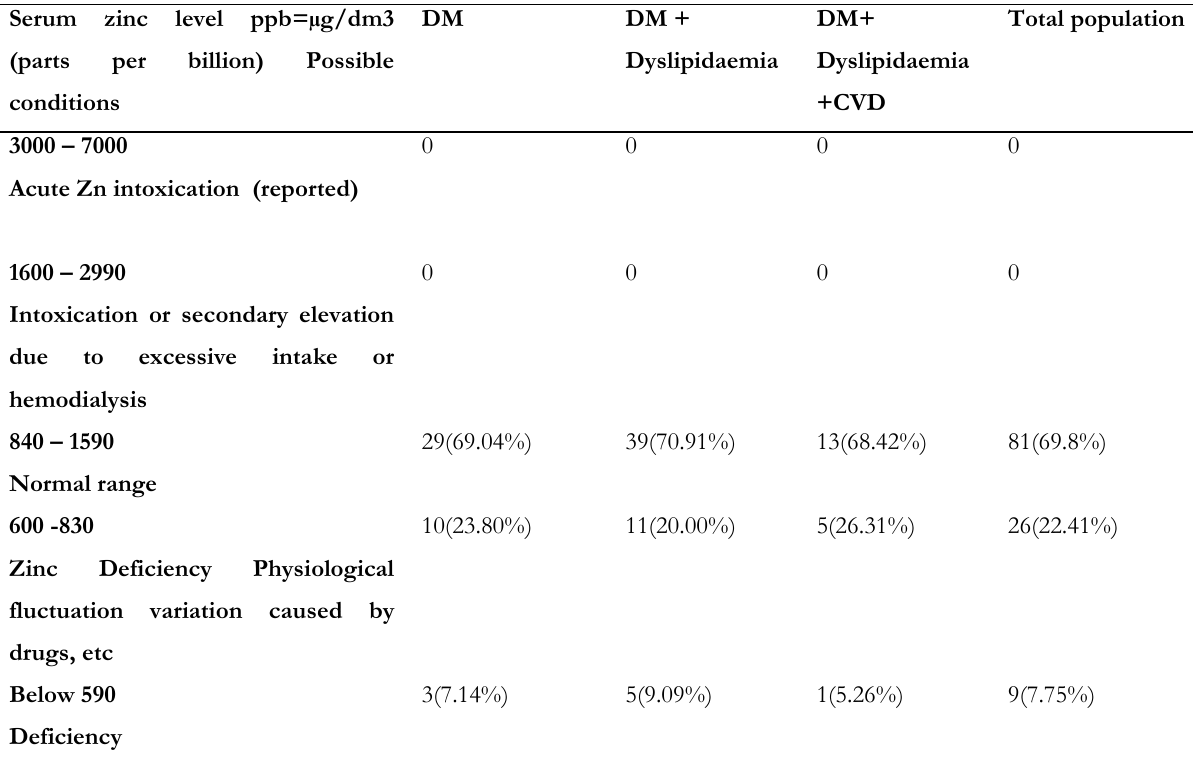
Table 3: Possible conditions and the population based zinc